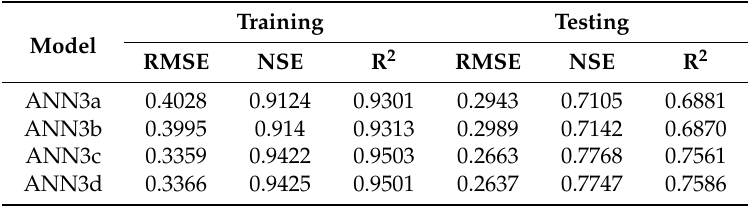
Table 9. Statistical measurement of 3 h forecasts for top 5% high water level